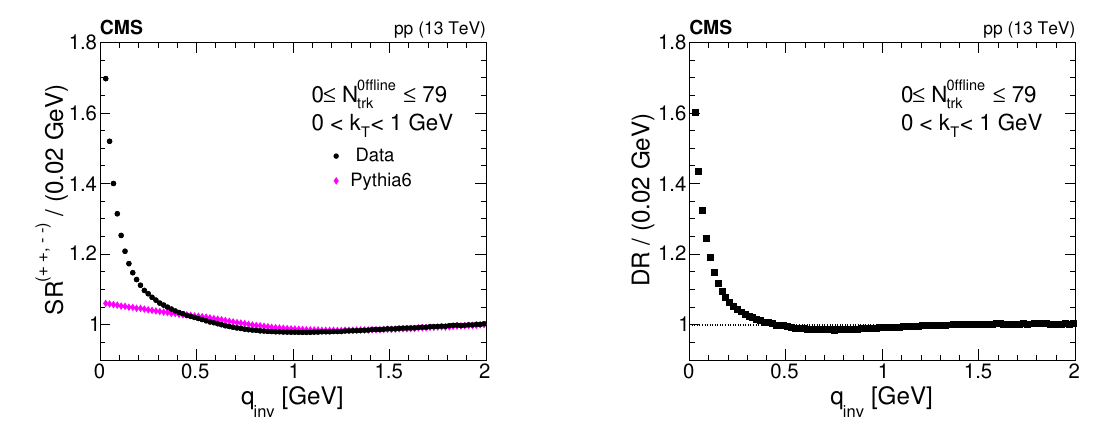
Figure 8 . Illustration of the steps in the double ratio method. The single ratio in data is con- structed (left), followed by a similar procedure with simulated events ( pythia 6, Z2* tune). The ratio of the two curves on the left de(cid:12)nes the double ratio (right). The reference sample is obtained with the (cid:17) -mixing procedure. All results correspond to integrated values in N o(cid:15)ine